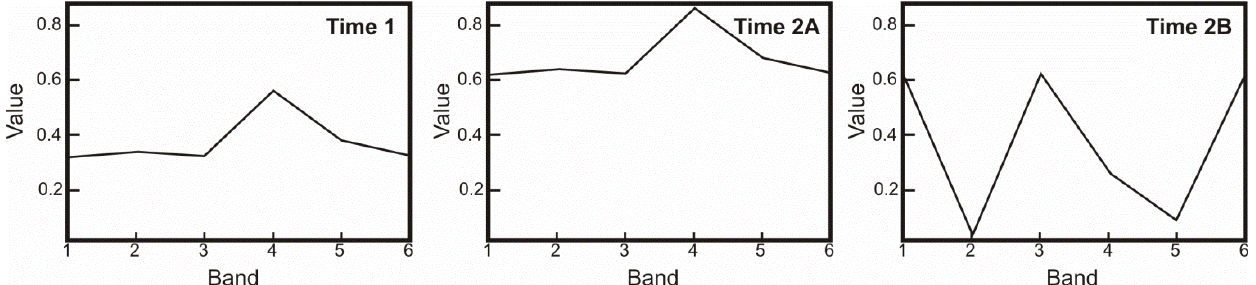
Figure 5. Comparison of a curve from time 1 ( t t − t (Euclidian distance, 0.735; and SCM, 1.0); and t 1 2a and SCM, − 0.350).